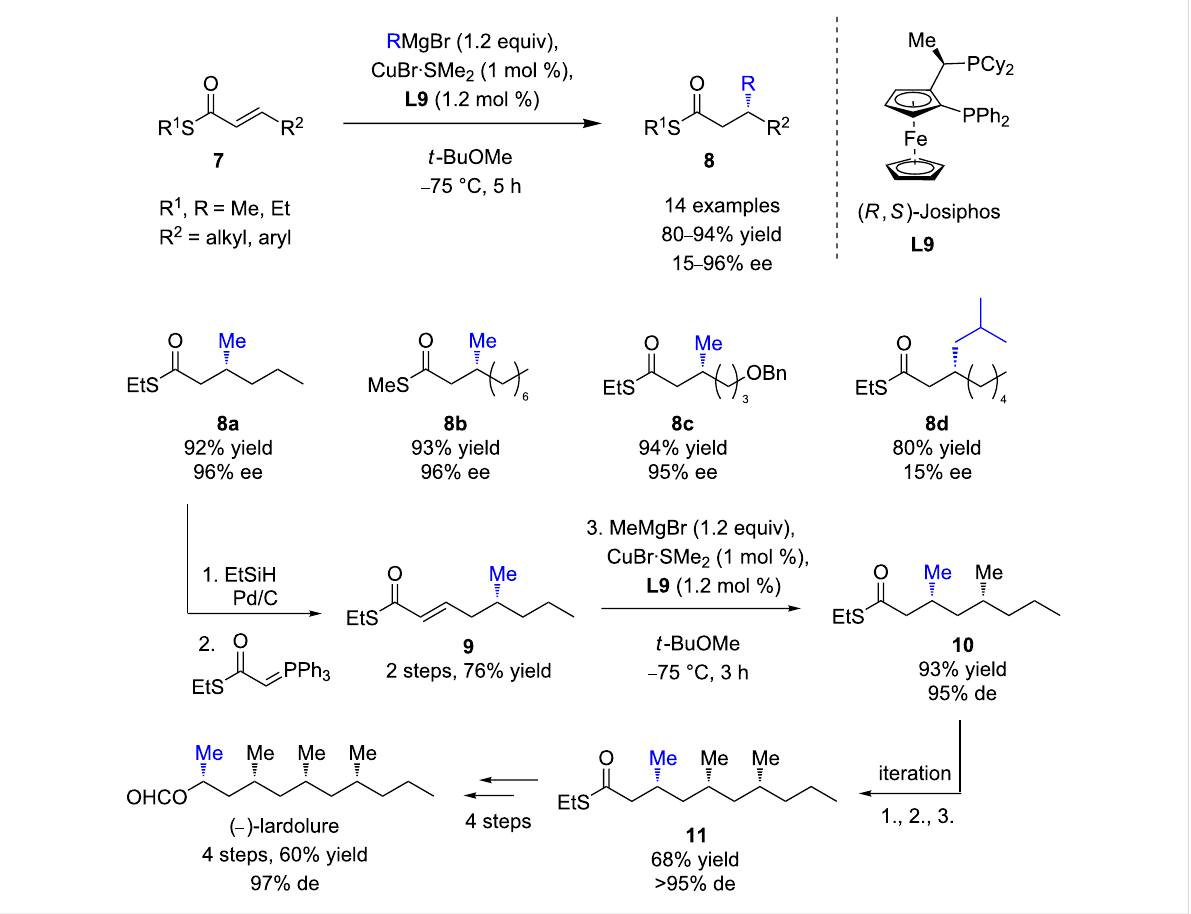
Scheme 6: CuECA of Grignard reagents to α , β -unsaturated thioesters and their application in the asymmetric total synthesis of